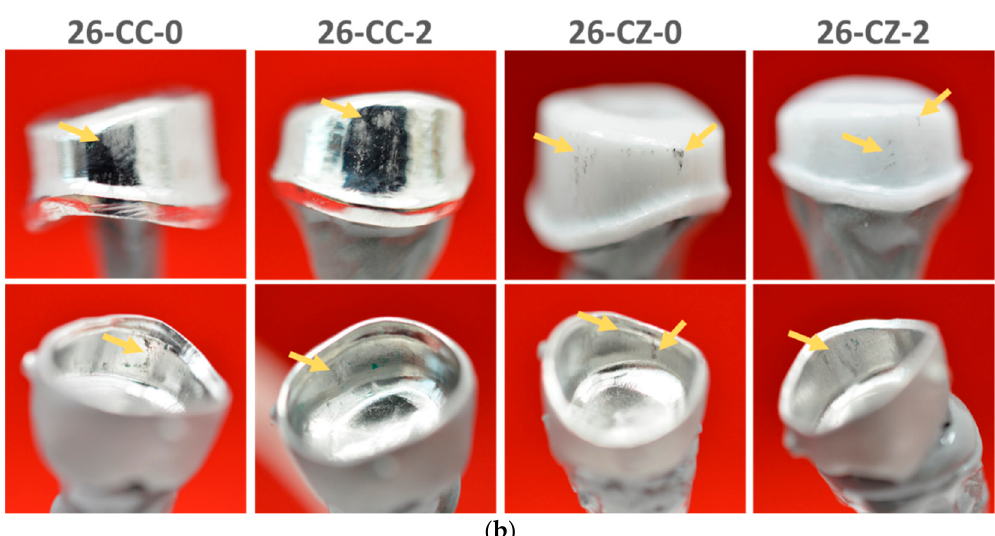
Figure 8. Macroscopic aspect of the telescopic system after the mechanical tests for 360 cycles (the arrows indicate the wear traces). ( a ) tooth 1.3 with taper angle of 0° and 2°, respectively and ( b ) tooth 2.6 with taper angle of 0° and 2°, respectively.